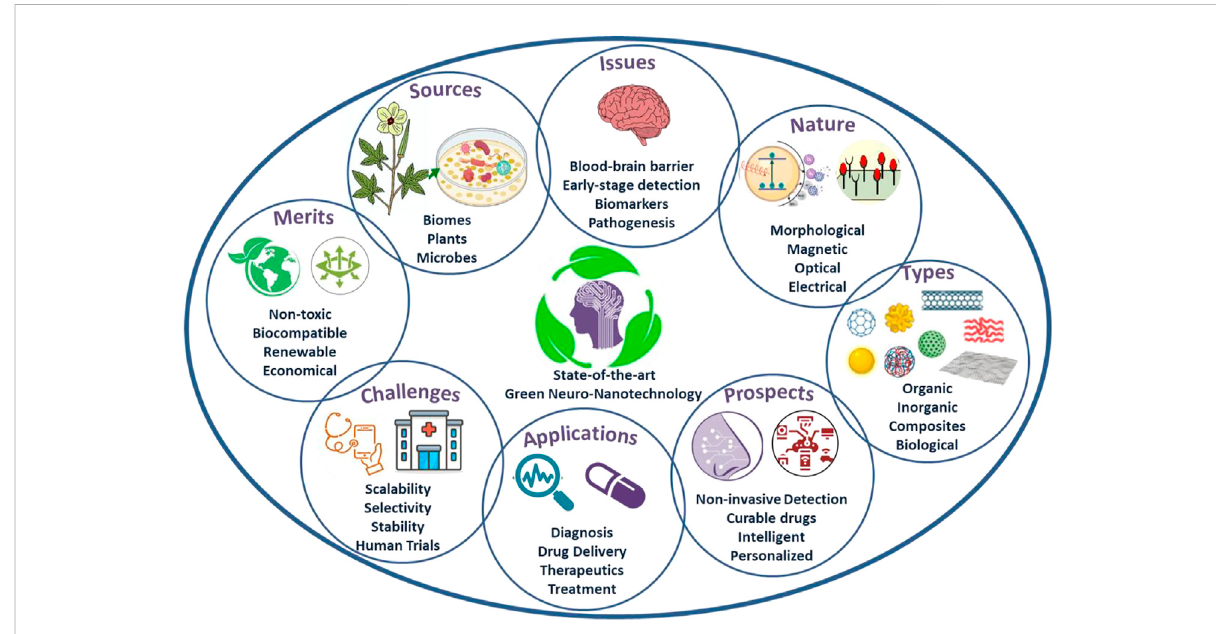
FIGURE 1 State-of-the-art Green Neuro-nanotechnology: Sources, issues, nature, types, merits, challenges, applications and